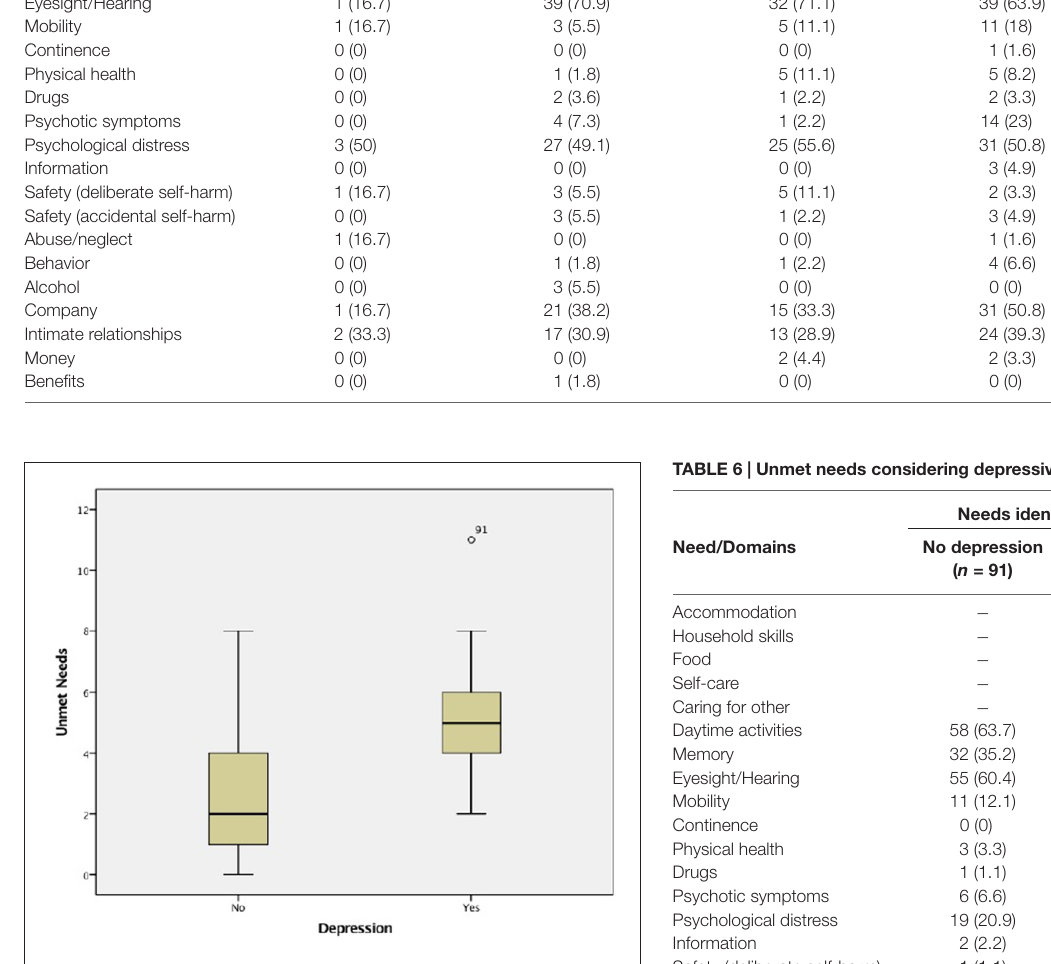
FIGURE 2 | Unmet needs considering depressive symptoms .